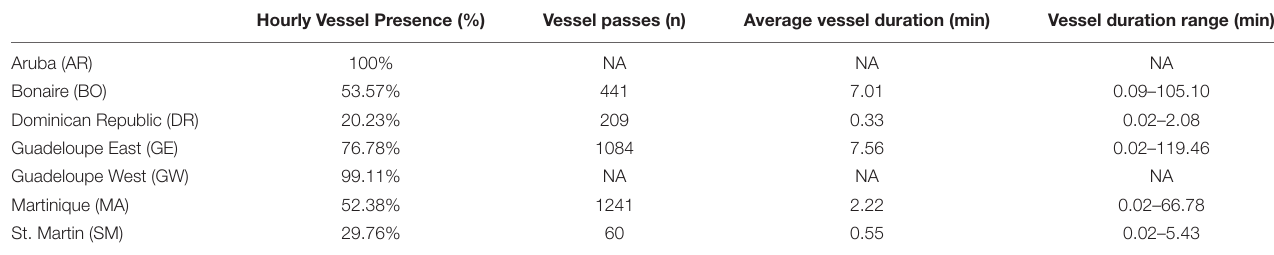
TABLE 2 | A summary of the hourly vessel presence at each recording site over a 2-week period between 12 March 2017 and 25 March 2017. Hourly Vessel Presence (%) Vessel passes (n) Average vessel duration (min)